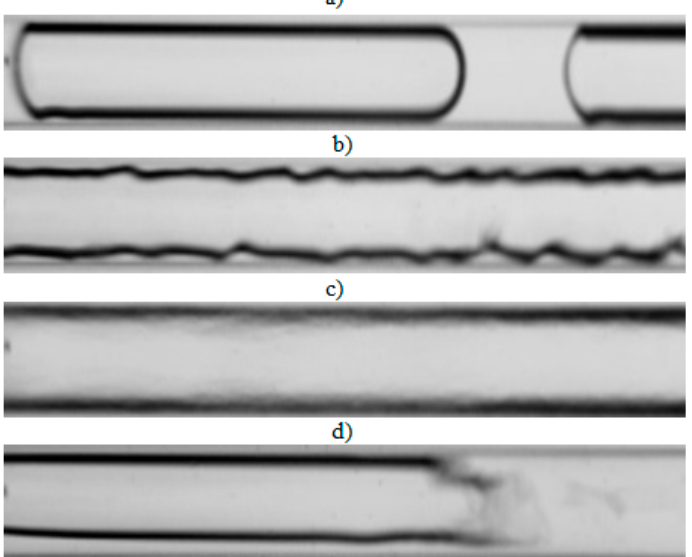
Figure 6. Experimental results of visualization research on HFE7000 refrigerant condensation in a minichannel with an internal diameter d h = 0.8 mm: ( a ) plug flow G = 197 kg/m 2 s, x = 0.004, ϕ = 0.44, t s = 31 °C; ( b ) annular ‐ wavy flow G = 369 kg/m 2 s, x = 0.012, ϕ = 0.69, t s = 32.5 °C; ( c ) annular flow G = 491 kg/m 2 s, x = 0.032, ϕ = 0.82, t s = 41 °C; ( d ) slug flow G = 639 kg/m 2 s, x = 0.003, ϕ = 0.34, t s = 29 °C.